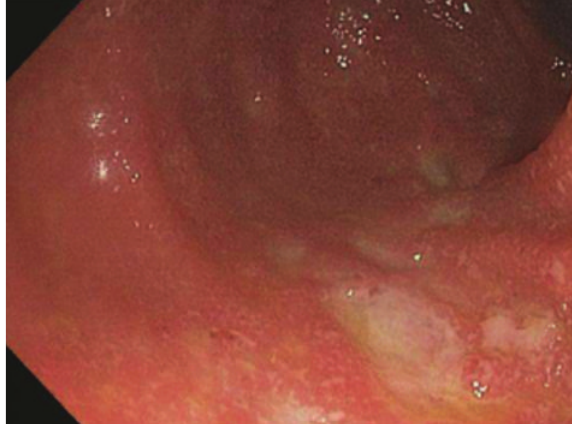
Figure 5: Ulcerated colonic mucosa, as viewed by colonoscopy, in a patient experiencing ipilimumab-related